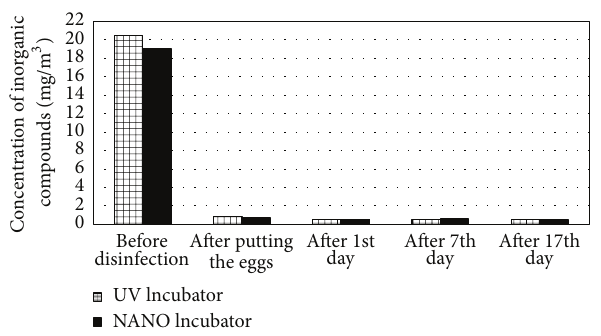
Figure 5: Concentration of inorganic gaseous compounds in the air inside the incubators during the incubation [mg/m 3 ].